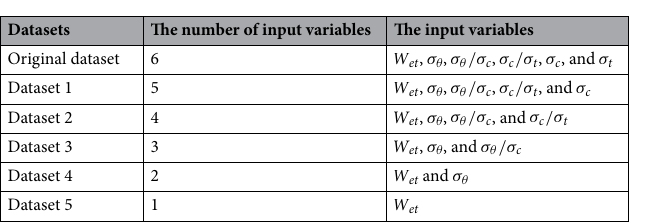
Table 14. The variation of input parameters.